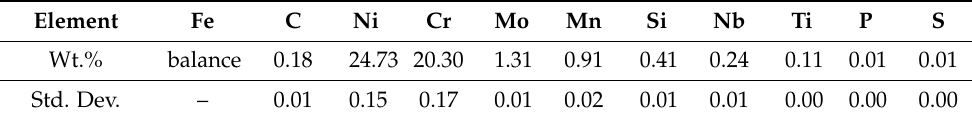
Table 1. The average chemical composition of the investigated steel, measured with optical emission spectrometry. Element Fe C Ni Cr Mo Mn Si Nb Ti P S Wt.% balance 0.18 24.73 20.30 1.31 0.91 0.41 0.24 0.11 0.01 0.01 Std. Dev. – 0.01 0.15 0.17 0.01 0.02 0.01 0.01 0.00 0.00